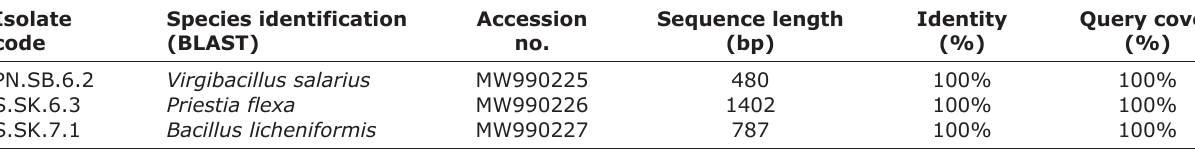
Table-3: Molecular identification of Semarang and Karimunjawa isolates. Isolate